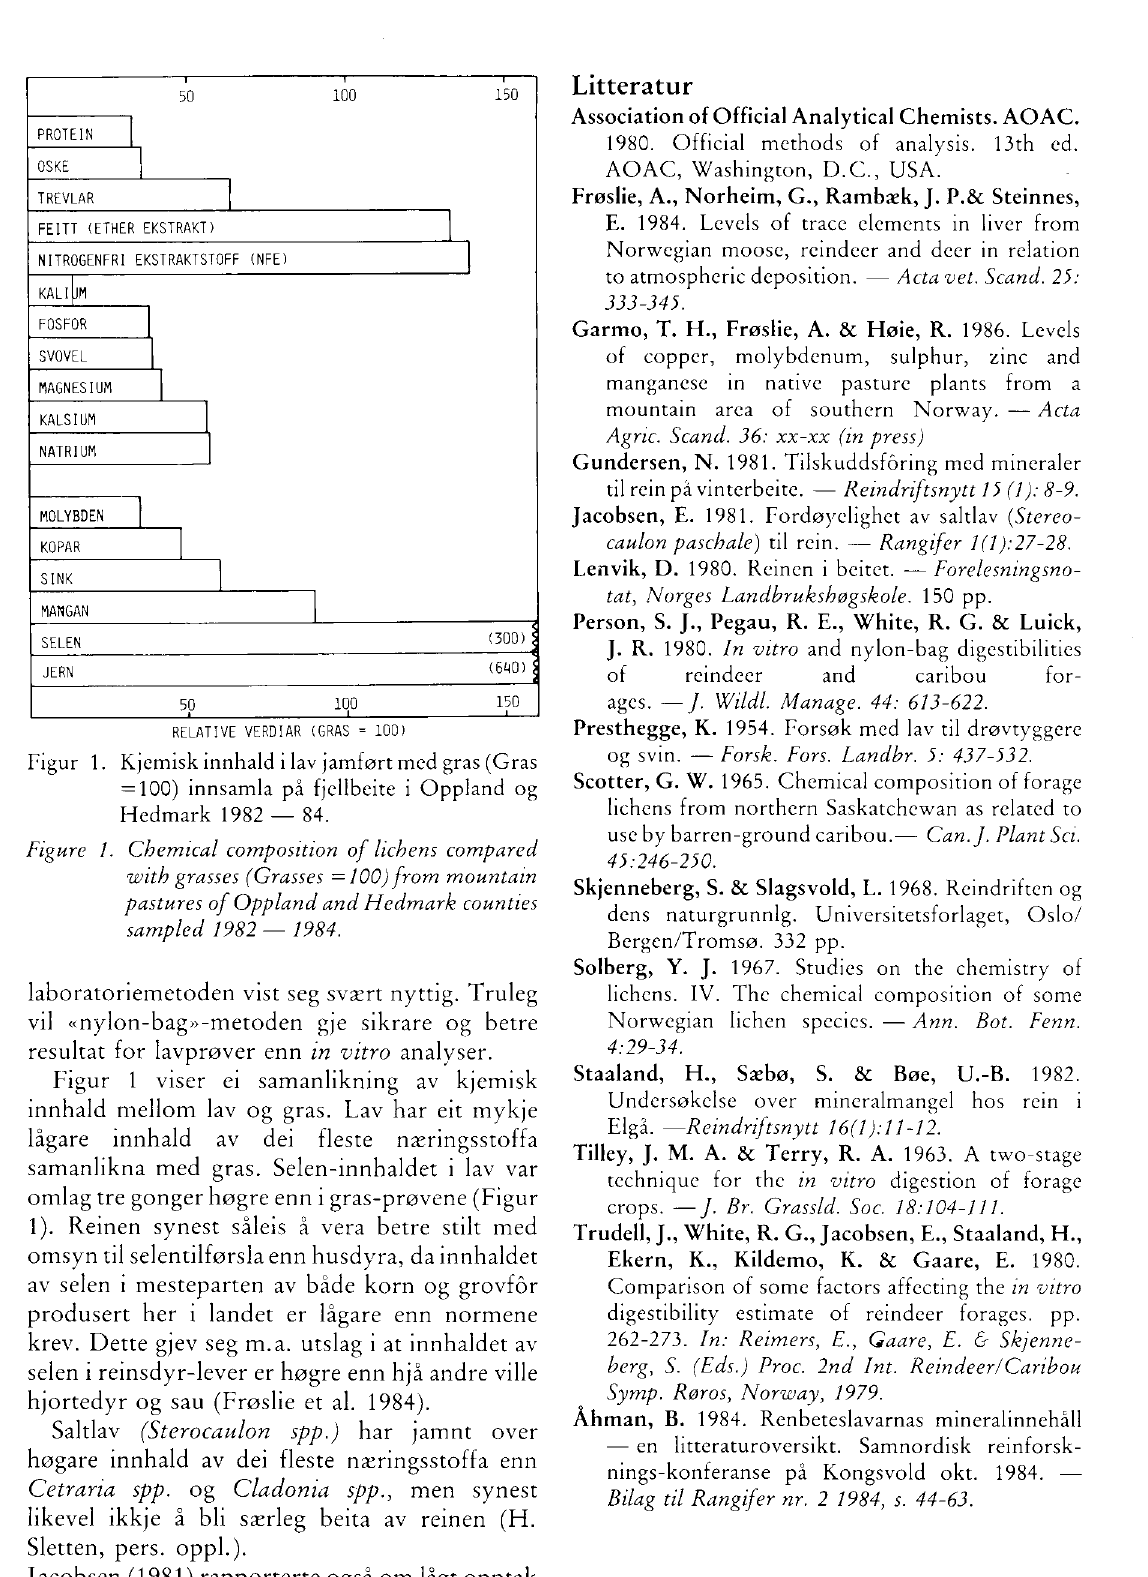
Figur 1. Kjemisk innhald i lav jamført med gras (Gras = 100) innsamla på fjellbeite i Oppland og Hedmark 1982 — 84. Figure 1. Chemical composition of lichens compared with grasses (Grasses =100) from mountain pastures of Oppland and Hedmark counties sampled 1982 — 1984. laboratoriemetoden vist seg svært nyttig. Truleg vil «nylon-bag»-metoden gje sikrare og betre resultat for lavprøver enn in vitro analyser. Figur 1 viser ei samanlikning av kjemisk innhald mellom lav og gras. Lav har eit mykje lågare innhald av dei fleste næringsstoffa omlag tre gonger høgre enn i gras-prøvene (Figur